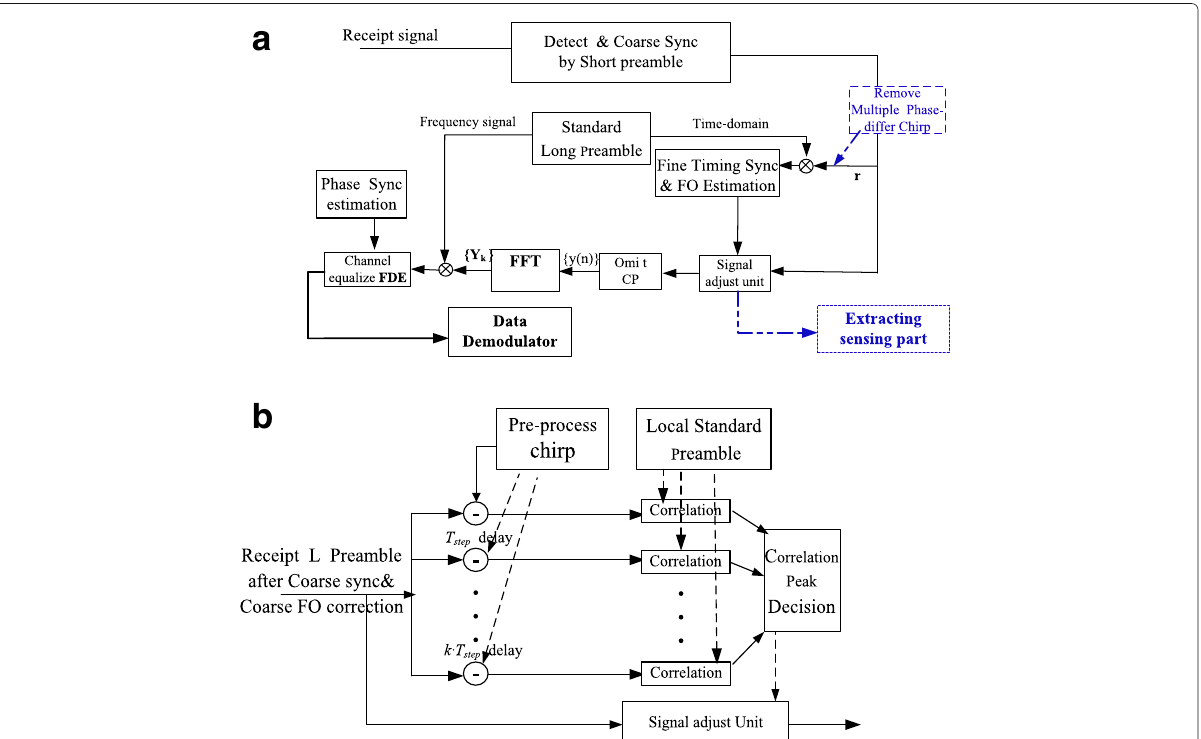
Fig. 2 Separate sensing and CE based on 802.11a. a Separate FO estimate, FDE and sensing. b Removal based on sliding parallel correlator